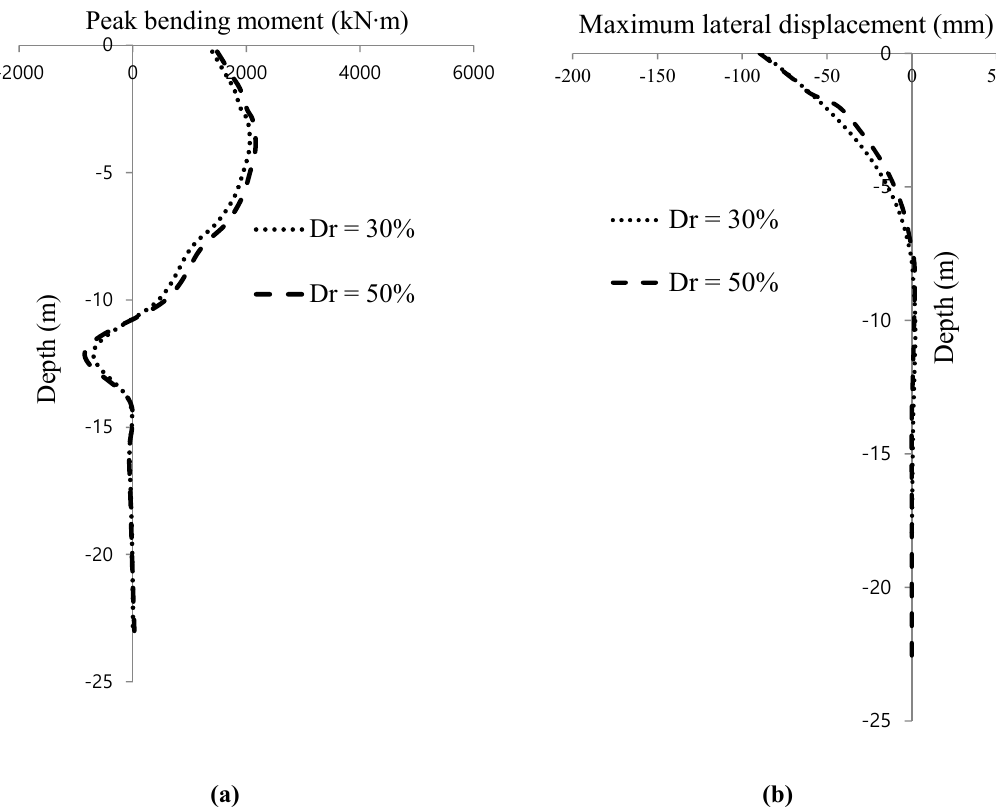
Figure 14. Dynamic pile response envelopes according to the relative density in dry condition: ( a ) Peak bending moment along the depth, ( b ) Maximum lateral displacement along the depth.